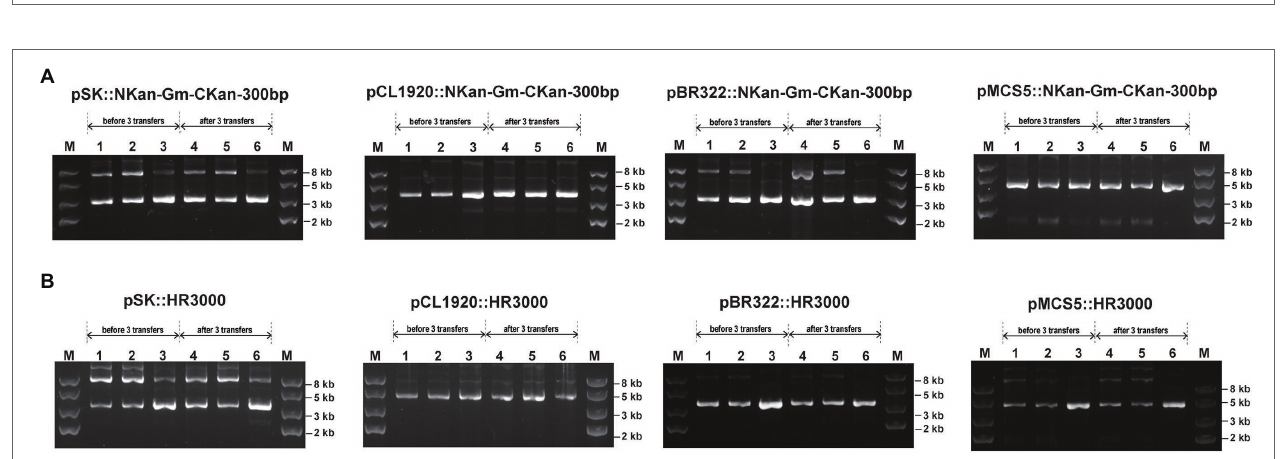
FIGURE 6 | The screen of plasmids multimerization with different replicons in E. coli BW25113 and E. coli BW Δ recA. The top two lines on the gel showed the plasmids that were transformed into either BW25113 (BW) or BW Δ recA ( recA − ). Note: The two lower bands in Lanes 3 and 4 are the relaxed form and supercoiled form of pBluescipt SK- monomer; the faint bands on top of Lane 3 are the dimer forms.